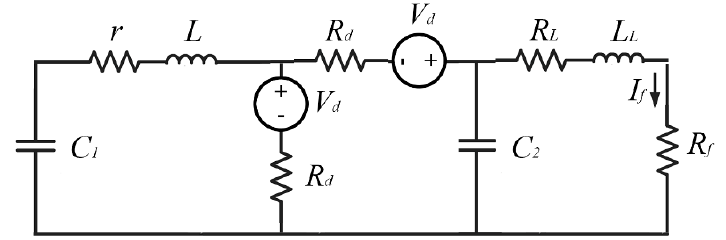
Figure 5. Equivalent circuit of DC/DC converter during the freewheeling diode operation. The differential equation of the fault current during the freewheeling diode stage for calculating the fault current in the time domain is shown in Equation